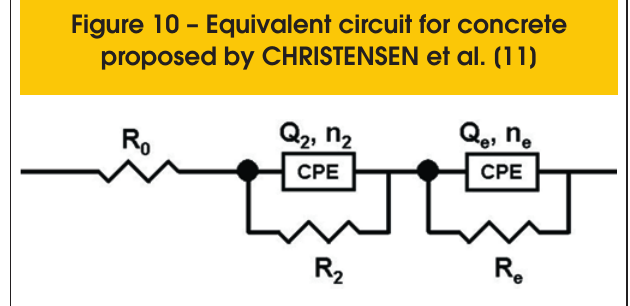
Figure 10 – Equivalent circuit for concrete proposed by CHRISTENSEN et al.